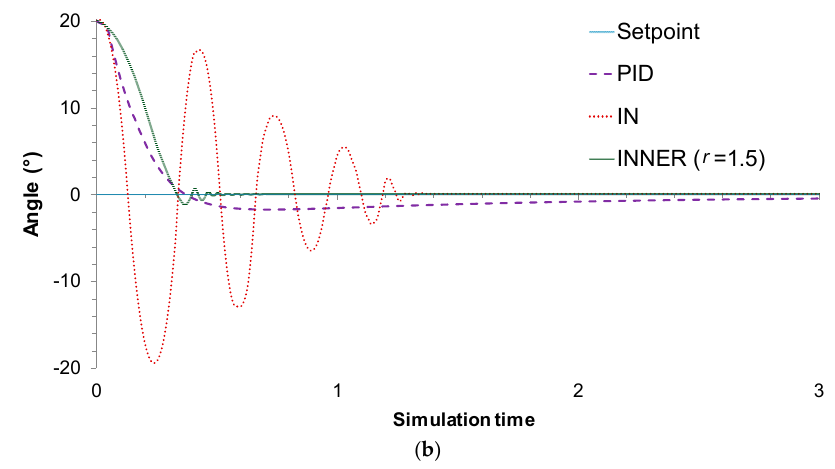
Figure 9. Inverted pendulum, ( a ) M = 1.4 kg: controller responses; ( b ) M = 2.0 kg: controller responses.